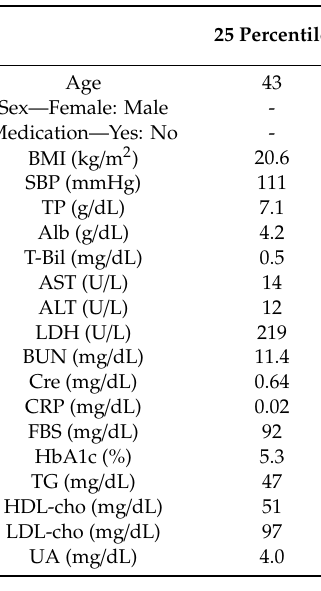
Table 2. Results of multivariable regression